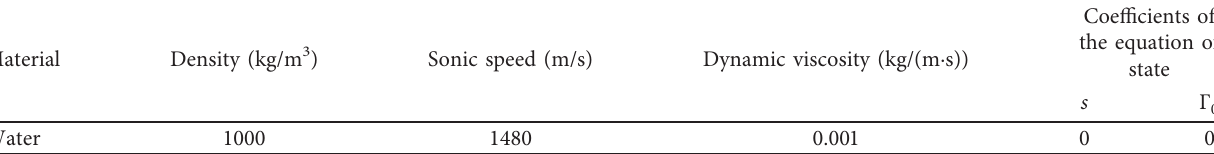
Table 1: Material properties of water.